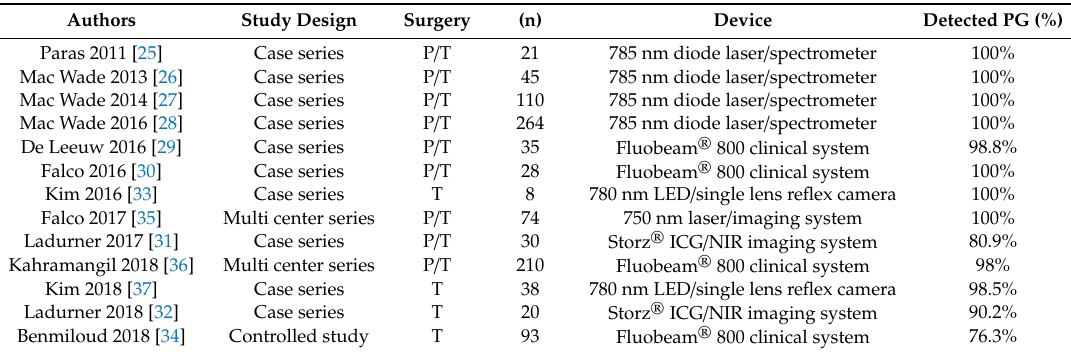
Table 2. Clinical studies applying NIR autofluorescence to identify parathyroid glands. (PG = parathyroid gland, P / T = parathyroidectomy / thyroidectomy; T = thyroidectomy). Authors Study